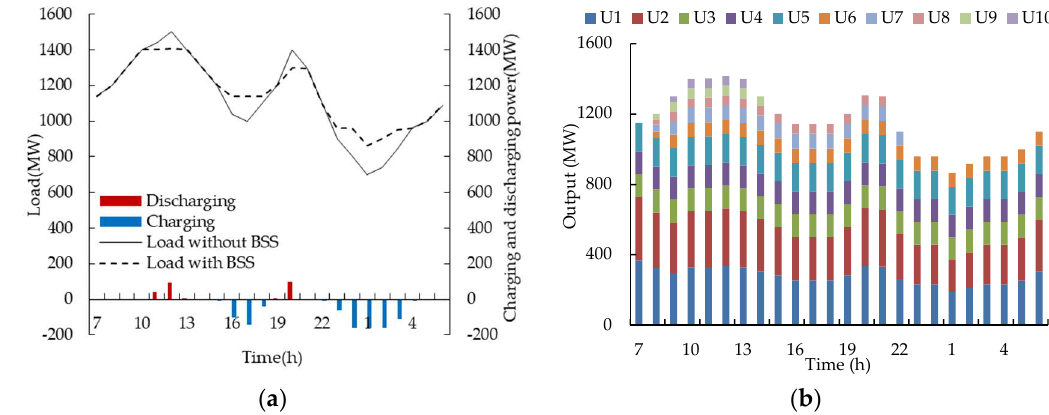
Figure 4. The optimization results of UC model: ( a ) The charging/discharging profile of BSSs; ( b ) The output of each unit in each period.